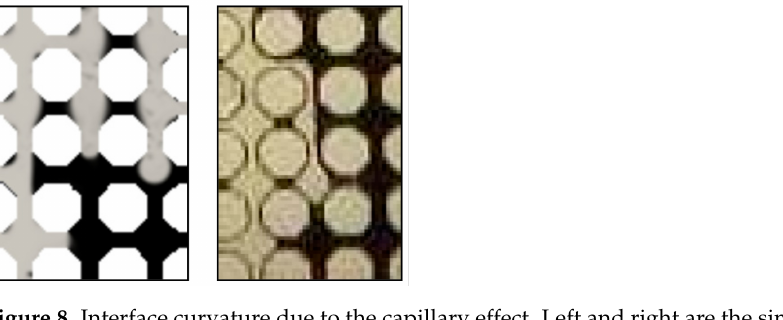
Figure 8. Interface curvature due to the capillary effect. Left and right are the simulator developed and experiment [31]. The black and grey colors show oil and solvent phases, respectively, and the white shapes are